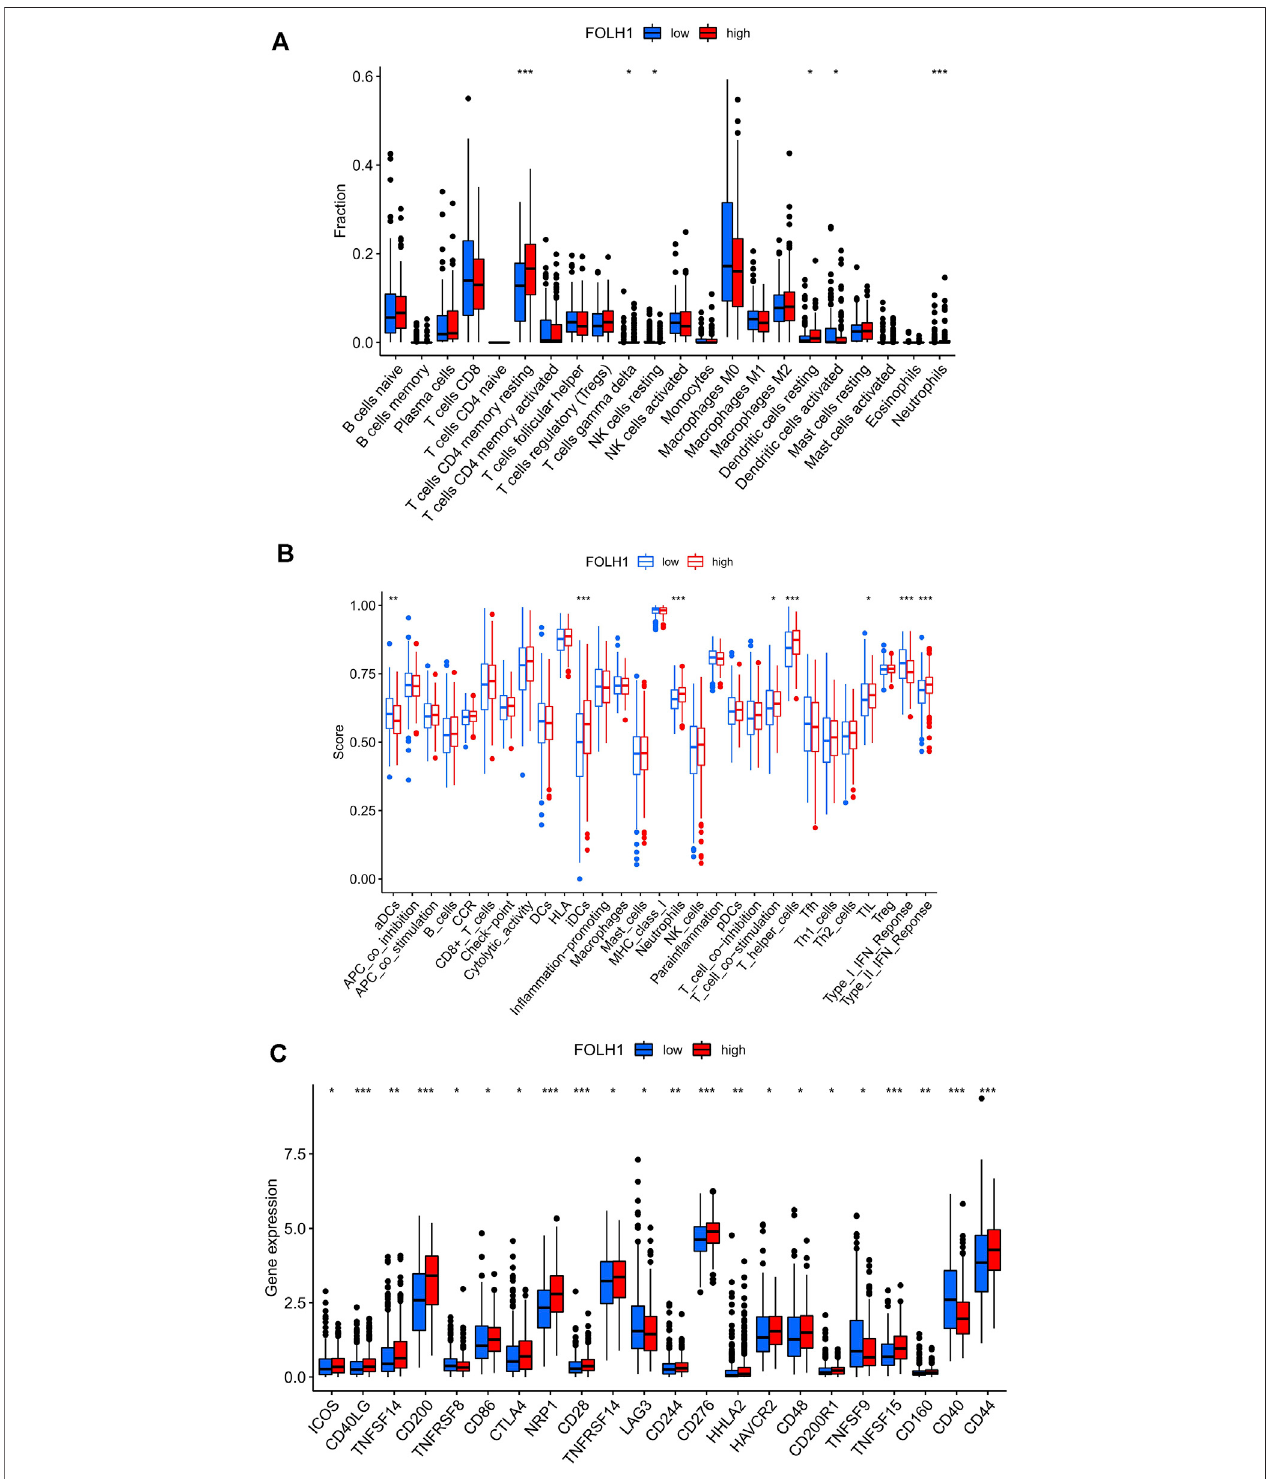
FIGURE 8 | Relationship between FOLH1 expression and in fi ltrating immune cells in the UCEC tumor-immune microenvironment. (A) The box plot shows the proportion difference of each immune cell between the low- and high-FOLH1 expression groups. (B) The landscape of in fi ltrating immune cells and immune function in the two groups. (C) The expression of FOLH1 was associated with key immune checkpoint genes in the tumor microenvironment (TME). The bottom and top of the boxes are the 25th and 75th percentiles (interquartile range). Blue: low risk, red: high risk. *** p < 0.001, ** p < 0.01, * p < 0.05.